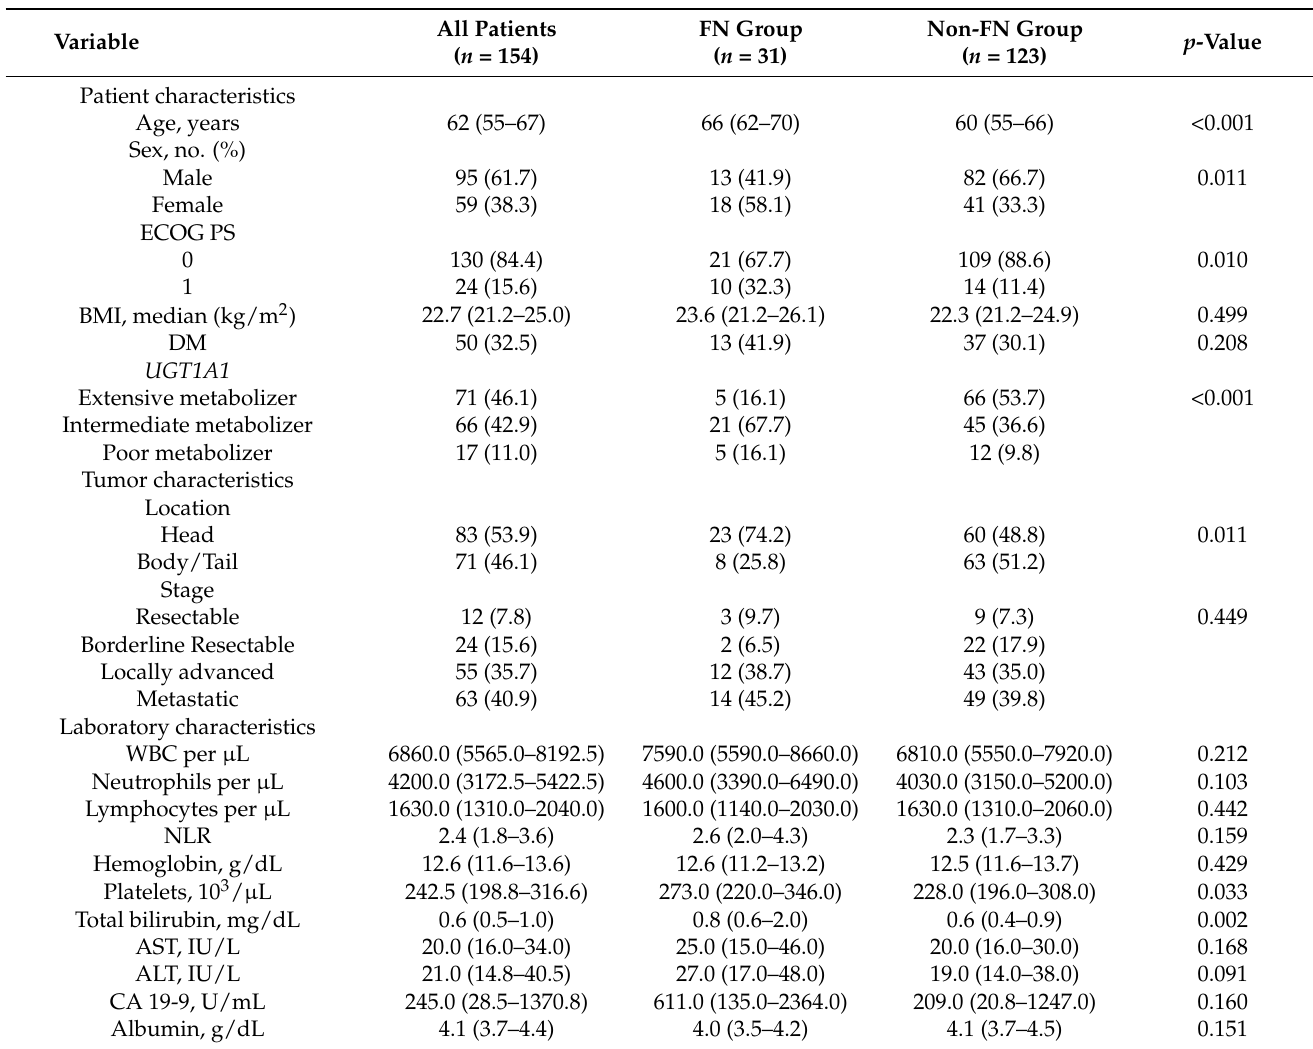
Table 1. Baseline